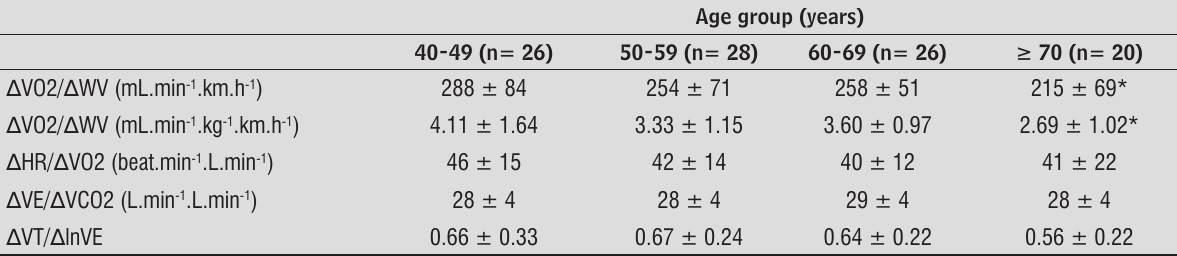
Table 3 - Dynamic physiologic responses to the incremental shuttle walk test according to age